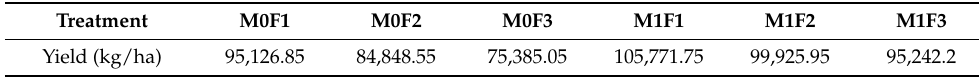
Table 5. Crop yields of different fertilizer application and magnetization.